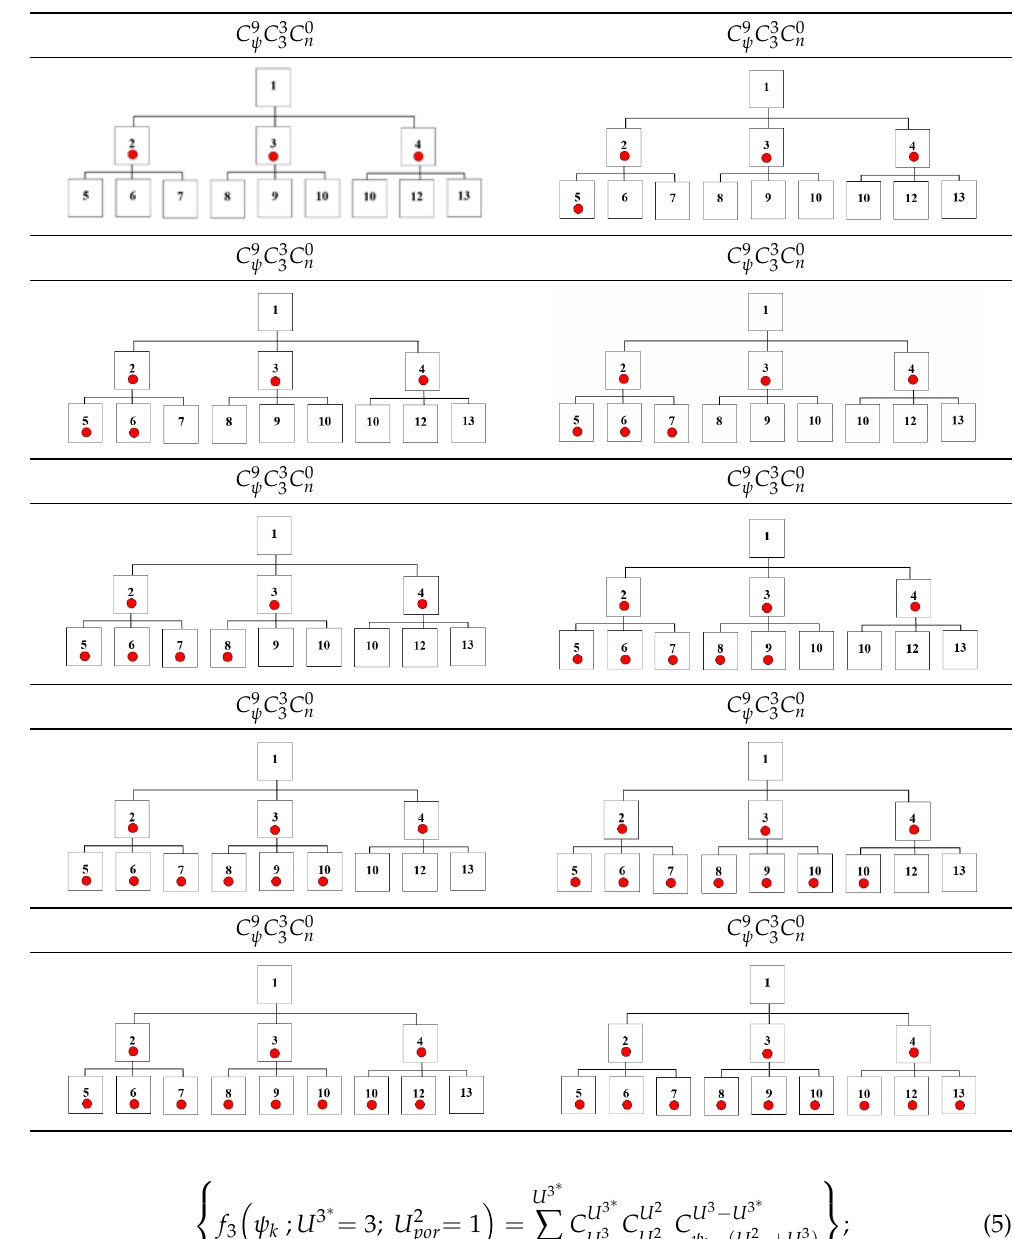
Table 3. Combinations of 2nd and 3rd levels for absorptions at 3 nodes of the 2nd